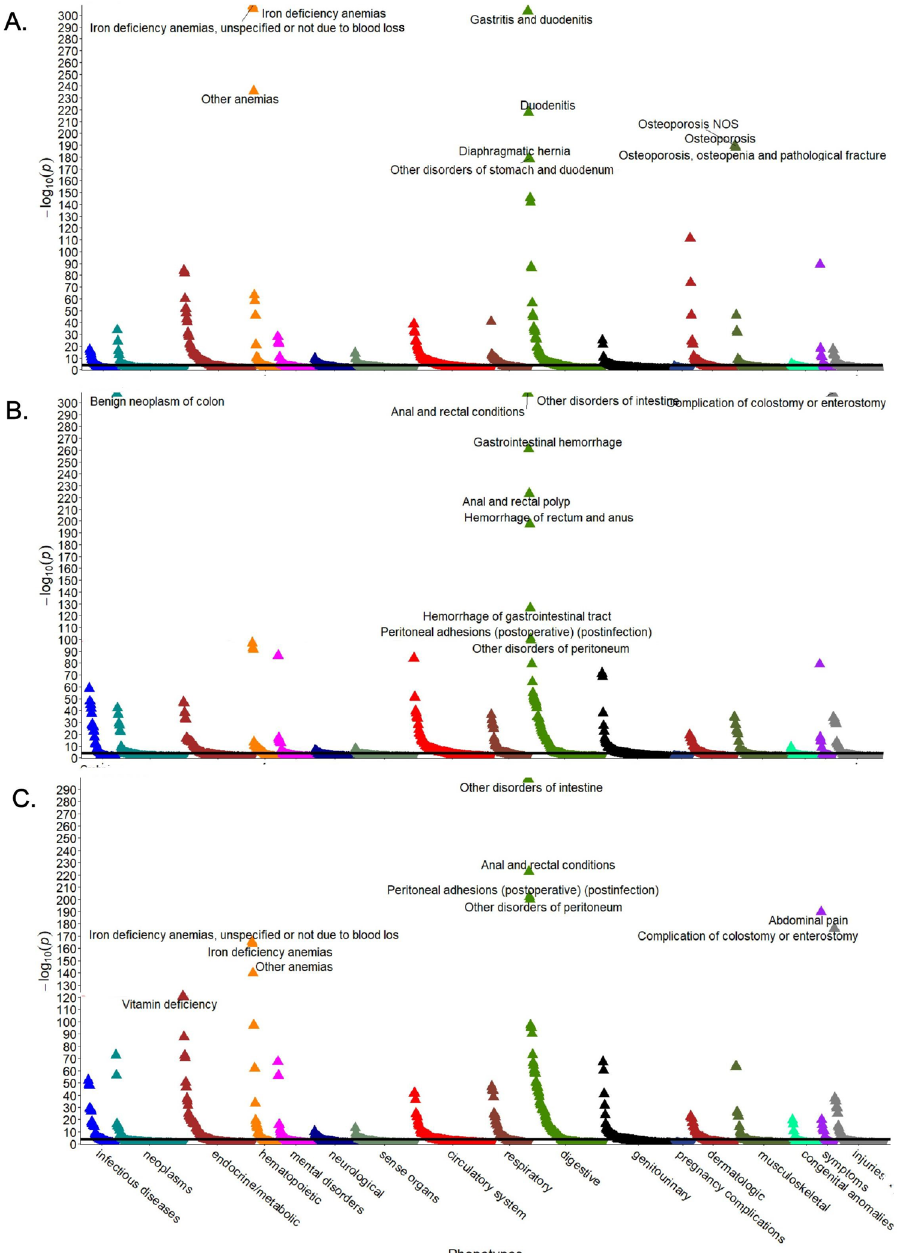
Figure 1. Conditions associated with CeD and IBD. Manhattan plots display Phecodes that are significantly over/underrepresented in individuals with coeliac disease ( A ), ulcerative colitis ( B ), or Crohn´s disease ( C ) compared with the reference group without these diagnoses. The ten most significant associations are shown. Upwards/downwards pointing triangles refer to Phecodes that are over/underrepresented. The black line indicates the significance level after Bonferroni adjustment for multiple testing. All analyses were adjusted for sex, age, and body mass index, and p values are displayed in a − log10 format. NOS not otherwise